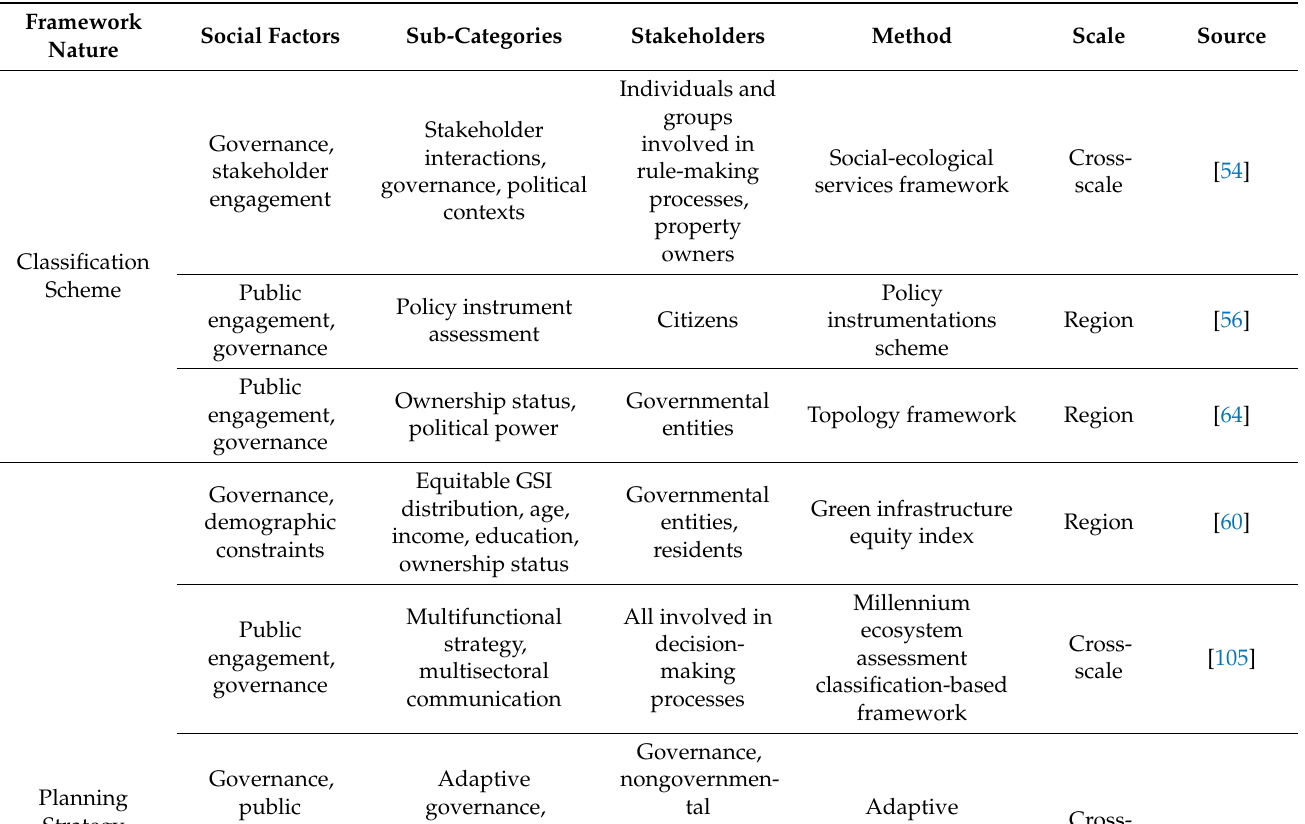
Table 2. Conceptual frameworks that consider social factors in GSI implementation